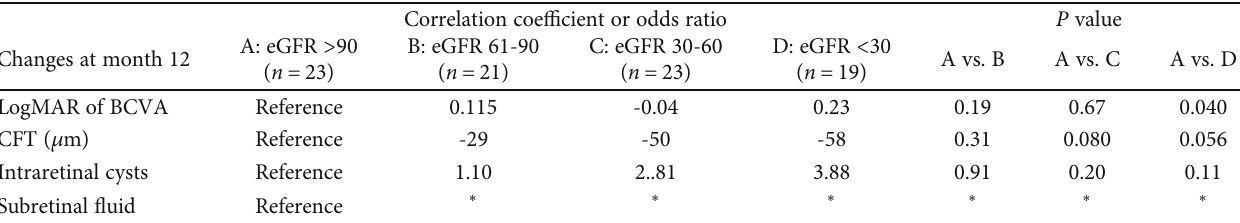
Table 4: Correlation between estimated glomerular fi ltration rate and changes in visual acuity and optical coherence tomography characteristics after Month 12 after ranibizumab